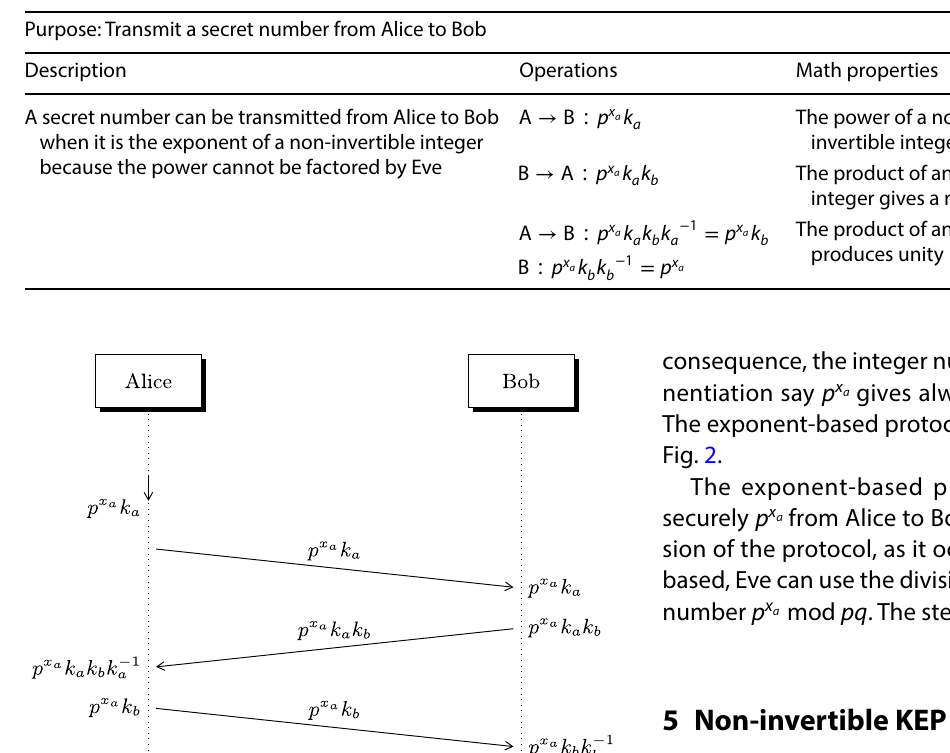
Table 4 Exponent-based protocol